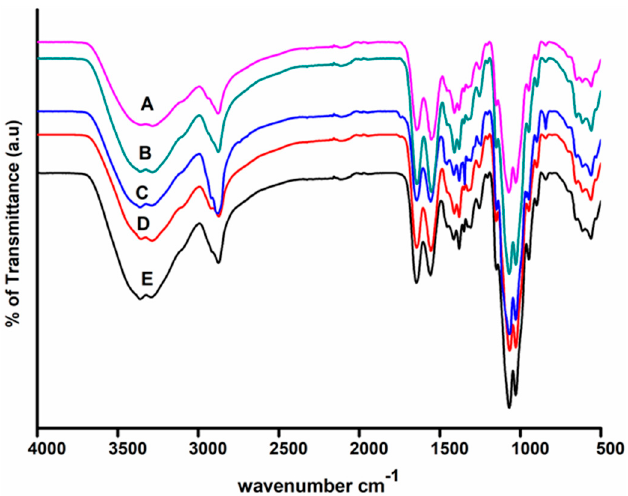
Figure 6. FTIR spectra of ( A ) CG (2% chitosan, 2% gelatin, 0.5% PEG, 0.075% AgNPs) ( B ) CG1 (2% chitosan, 2% gelatin, 0.5% PEG, 0.0075% AgNPs) ( C ) CG2 (2% chitosan, 2% gelatin, 0.5% PEG, 0.0125% AgNPs) ( D ) CG3 (2% chitosan, 2% gelatin, 0.5% PEG, 0.025% AgNPs) ( E ) CG4 (2% chitosan, 2% gelatin, 0.5% PEG, 0.05% AgNPs).